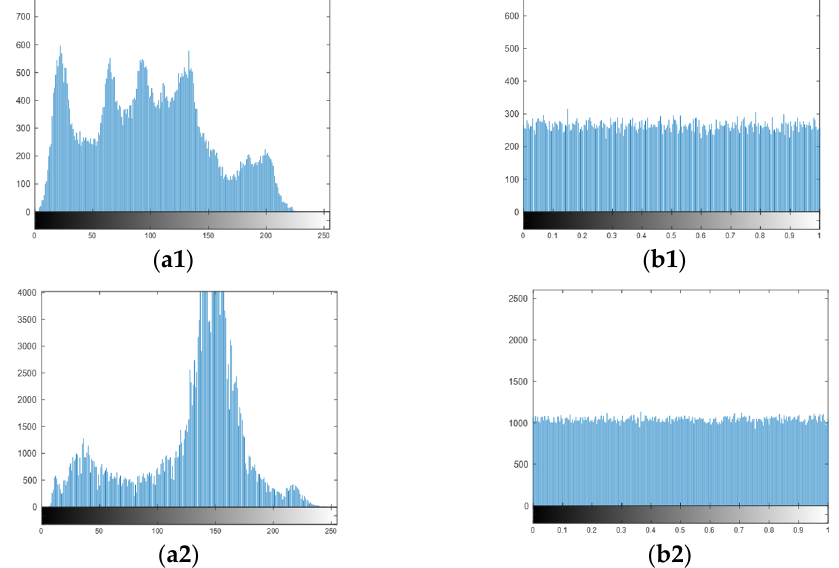
Figure 8. Histogram analysis. ( a1 , a2 ) Plain image histograms; ( b1 , b2 ) encrypted image histograms.